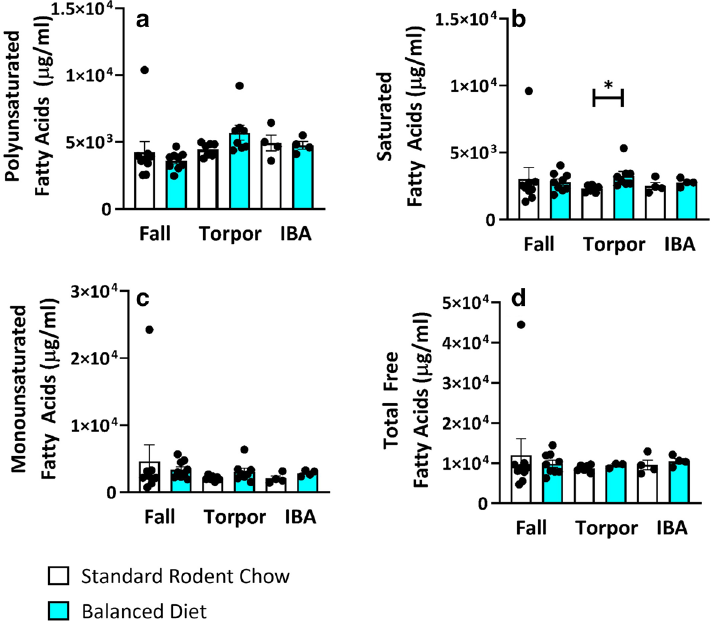
Figure 2. In plasma, Balanced Diet does not increase Total PUFAs ( a ), MUFAs ( c ) or Free Fatty Acids ( d ). Balanced Diet does increase saturated fatty acids during torpor ( b ). *p < 0.05, two-tailed t-test, FDR corrected. Data shown are mean ± SEM. Black dots are individual data points. Fall n = 9, Torpor n = 7–8, IBA n = 4 per